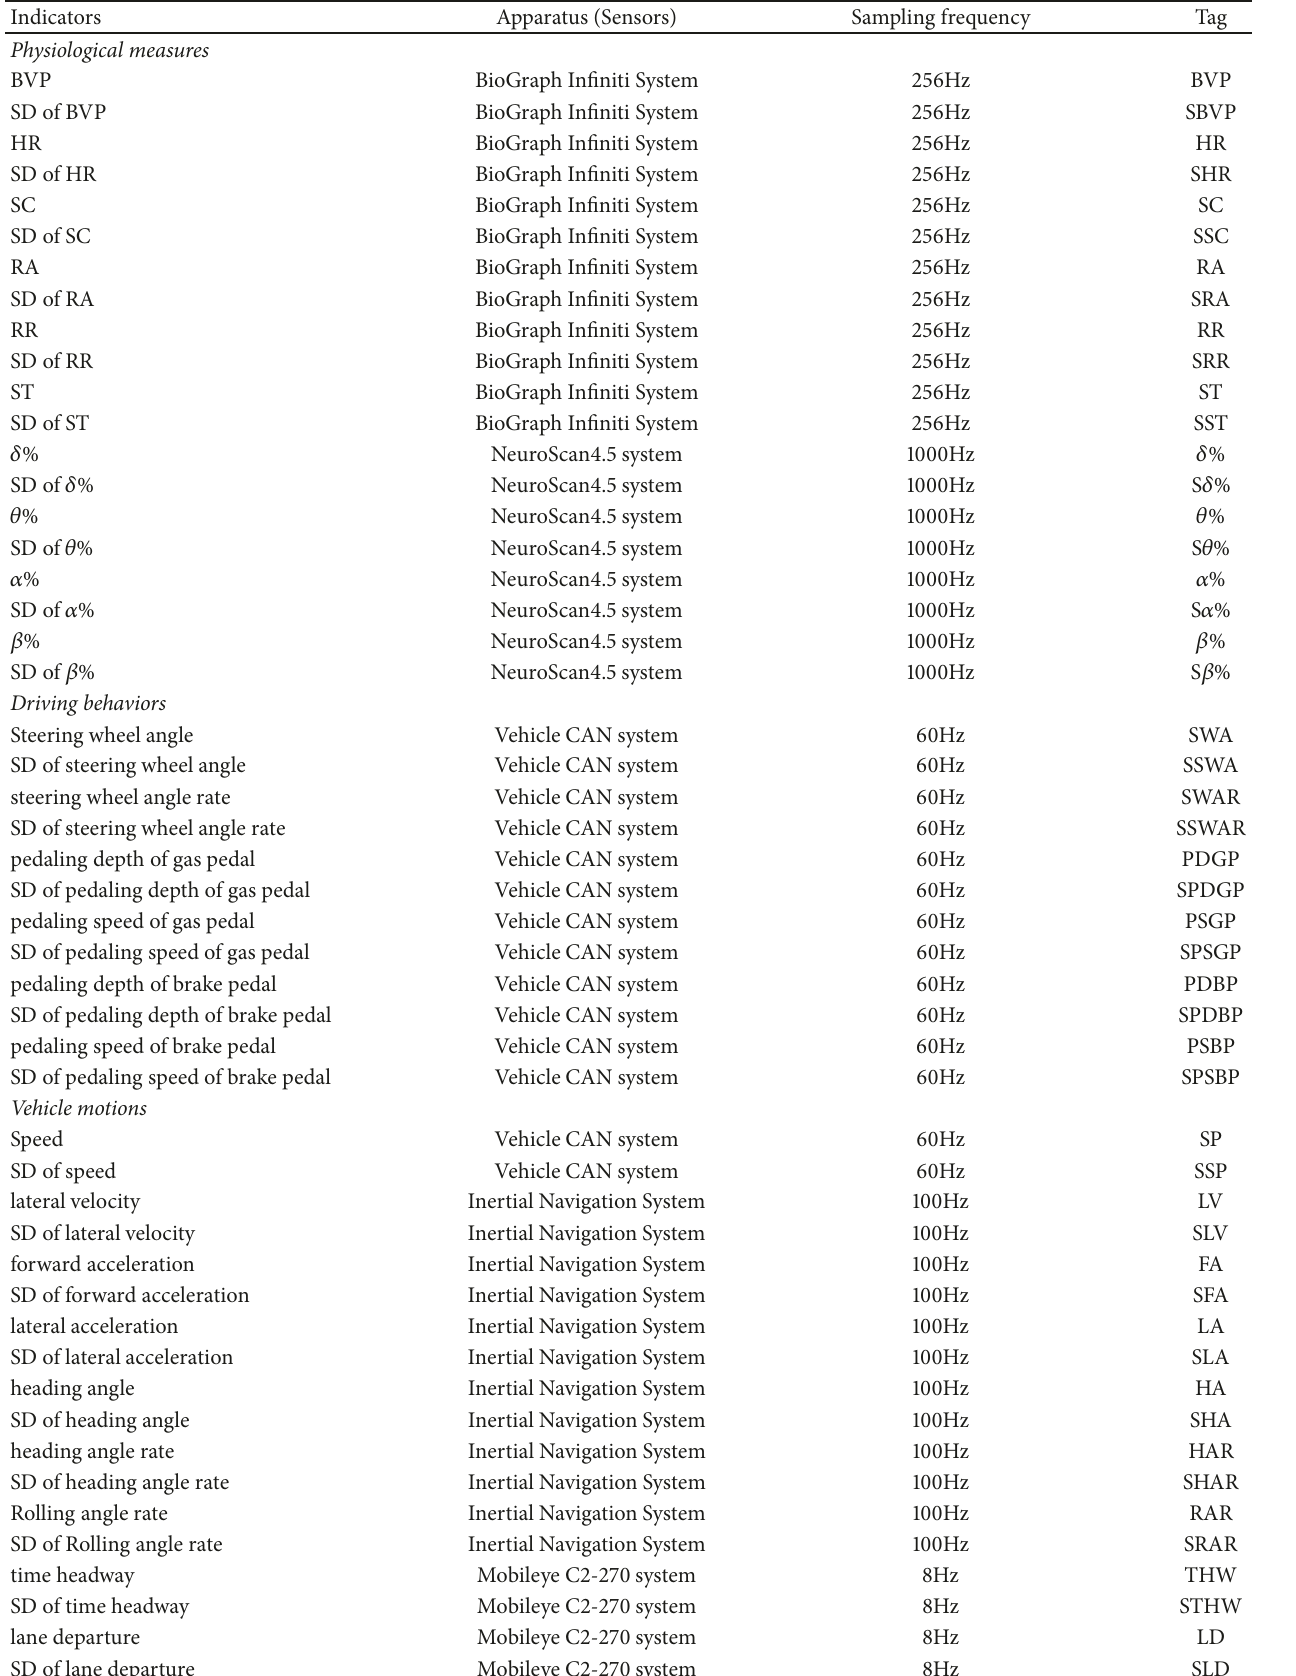
Table 1: Brief introduction of multisensors based data